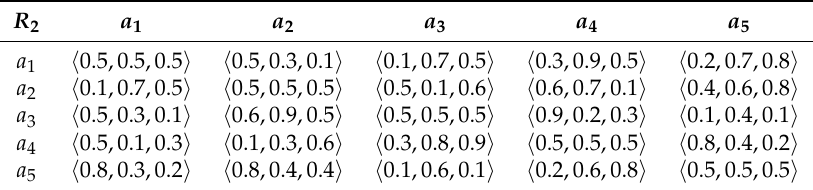
Table 2. SVNPR of the expert from the human resources department.